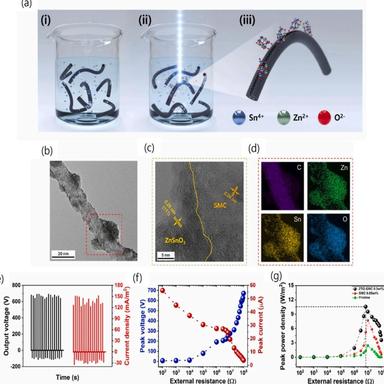
(a) Schematic of the formation of ZTO-SMC. (b, c) HR-TEM images of ZTO-SMC. (d) Elemental mapping profile in C, O, Zn, Sn in ZTO-SMC. (e) Output voltage and current density of the ZTO-SMC PDMS-based TENG under repetitive contact-separation mode. (f, g) Peak voltage, peak current, and peak power density under different external resistances. Adapted from "Laser-driven formation of ZnSnO3/CNT heterostructure and its critical role in boosting performance of the triboelectric nanogenerator," by K. Lee, H. Han, J